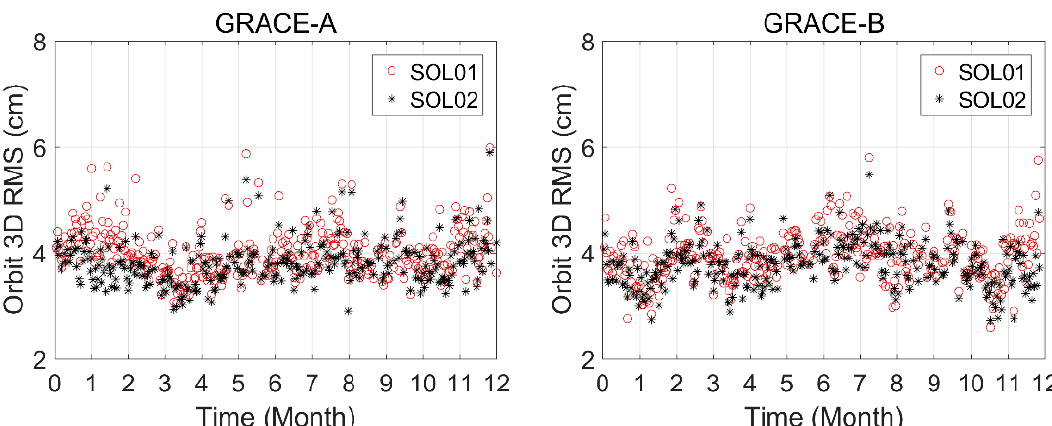
Figure 5. 3D RMS of GRACE-A/B orbits from SOL01 and SOL02 determined using different Level-1B observations (RL02 and RL03).